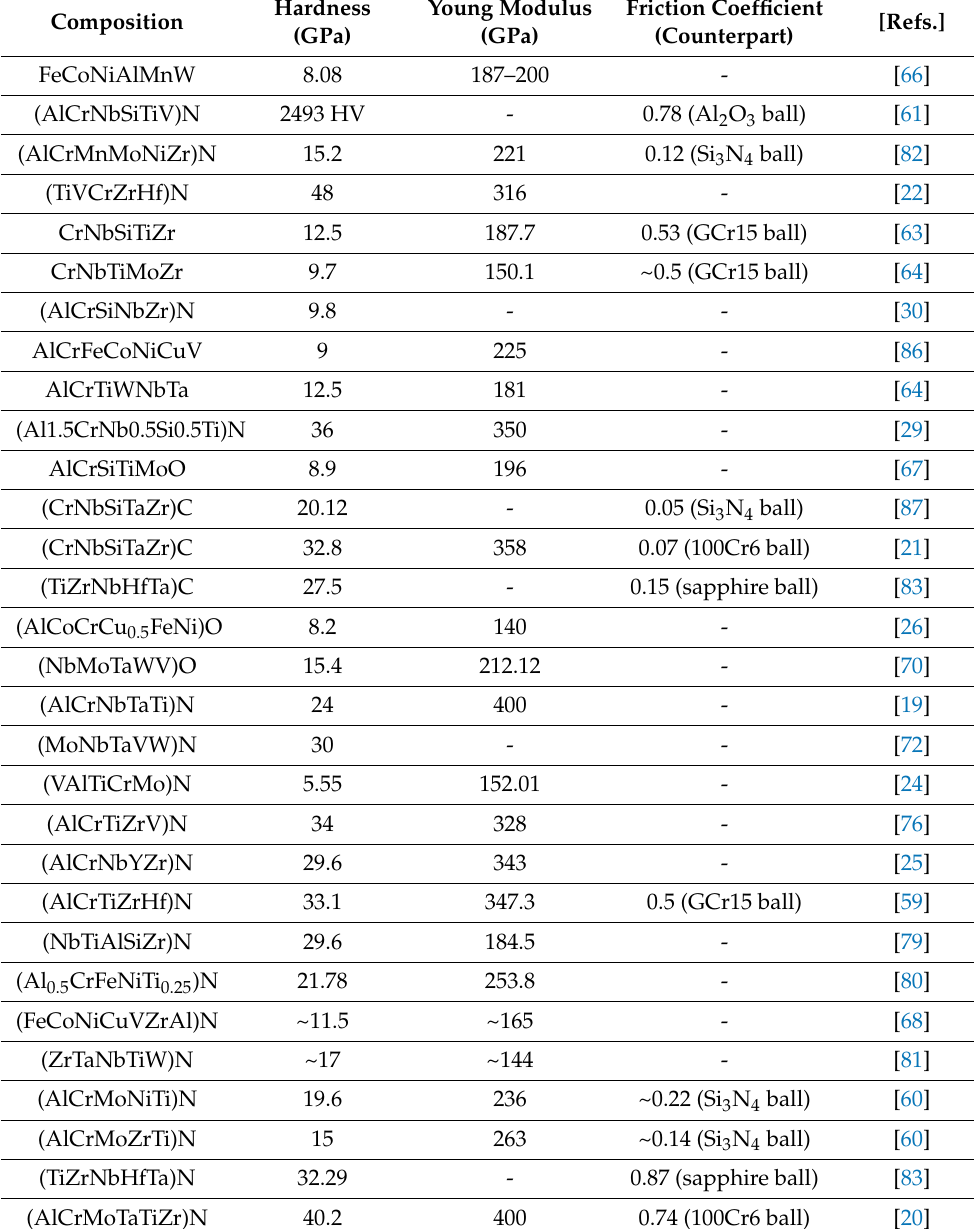
Table 2. Hardness, Young’s modulus (only high values) and friction coefficient (low values) of HEFs prepared by magnetron sputtering, at different parameters, in the last 10 years. The values highlight the best obtained results of each